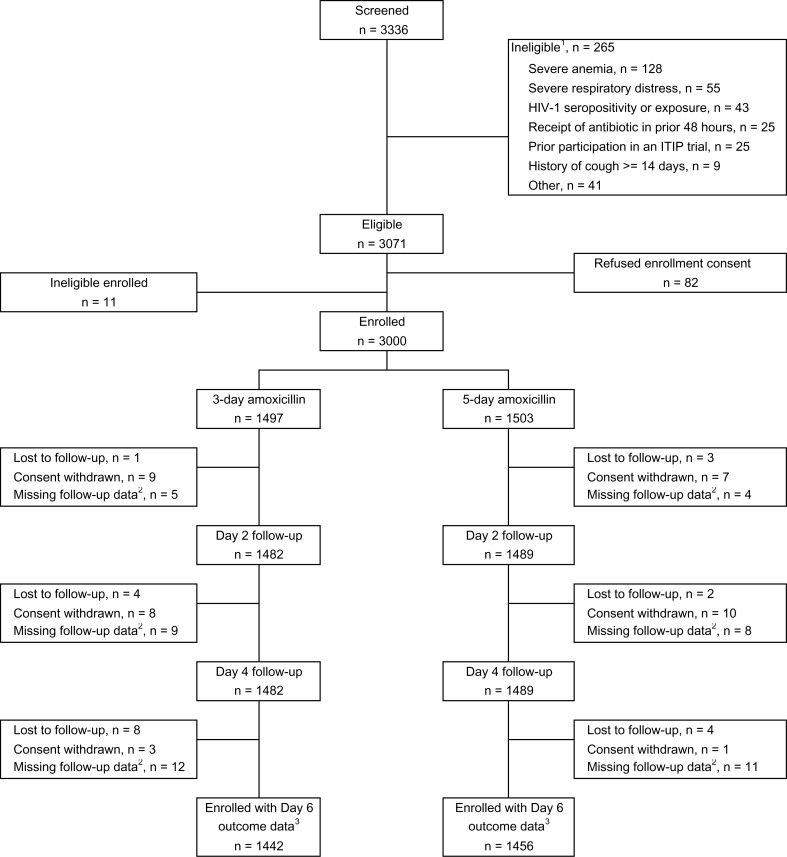
Consort diagram by treatment group1Children may be ineligible for more than one reason.2Missing follow-up data may be due to missed visits or visits occurring
outside visit windows.3Missing follow-up data n’s do not add up because some children had
missing follow-up data for either Day 2 or Day 4 or both, but had outcome data available
for Day 6.